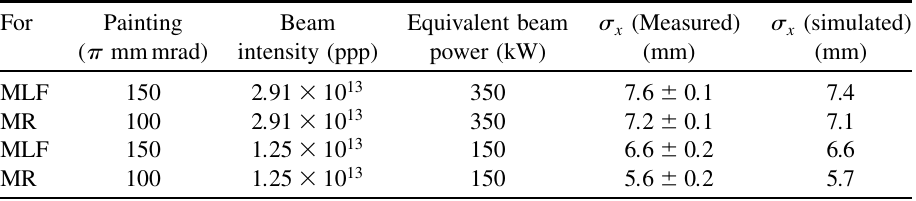
TABLE II. A list of the beam parameters and the corresponding measured and simulated horizontal rms width of the extracted beam at 3 GeV. The studies were done for two beam intensities. One is for a present maximum beam power of 350 kW, while the other one was for a comparatively lower beam power of 150 kW at the extraction energy. The painting area for the MLF and MR was 150 and 100 (cid:1) mm mrad , respectively. As expected, extracted beam profiles for the MR are measured to be narrower as compared to those for the MLF. The difference is more significant for a comparatively low intensity beam. The corresponding quantitative simulation results are also found to be consistent with measured